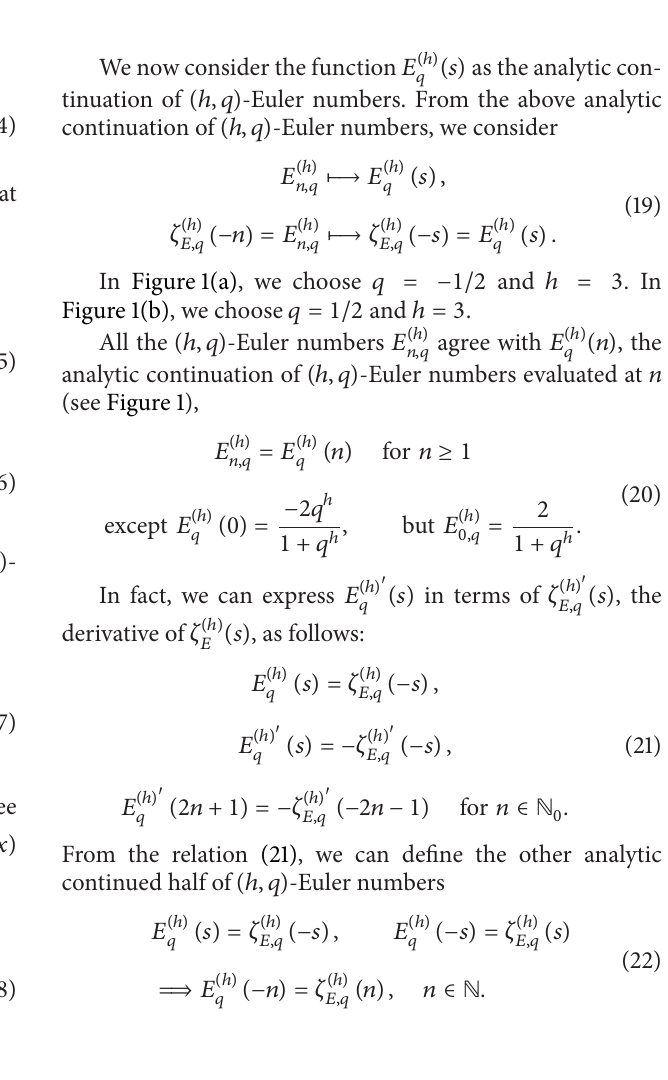
Figure 1: The curve 𝐸 (ℎ) 𝑞 (𝑠) runs through the points of all 𝐸 (ℎ) 𝑛,𝑞 except 𝐸 (ℎ) 0,𝑞